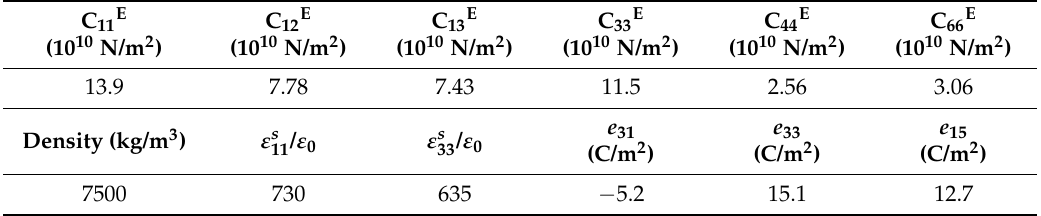
Table A1. Material properties of piezoelectric ceramic